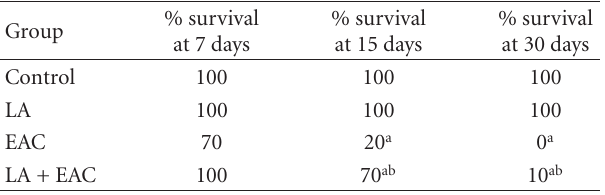
Table 2: E ff ect of 50mg/kg body wt oral administration of α -lipoic acid (LA) on percent of survival of mice from carcinogenic assault by Ehrlich ascites carcinoma (EAC) cells.